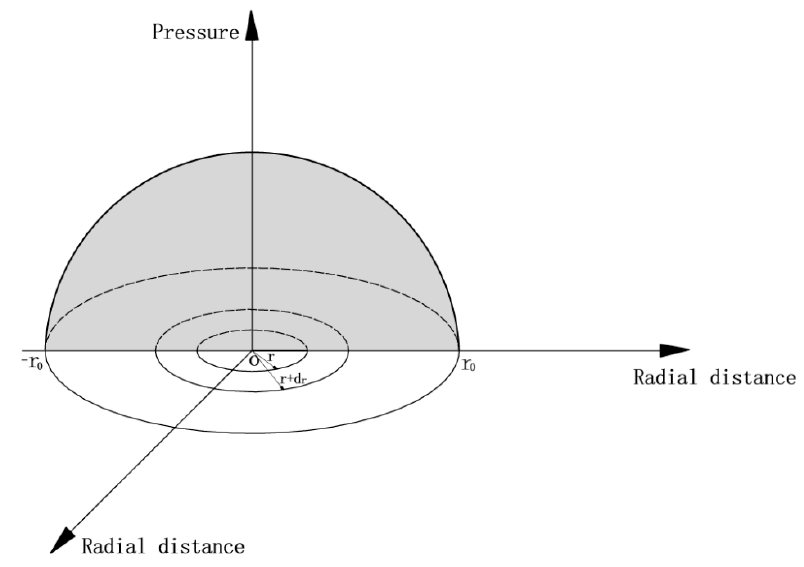
Figure 5. Spatial distribution of laser induced shock wave pressure.